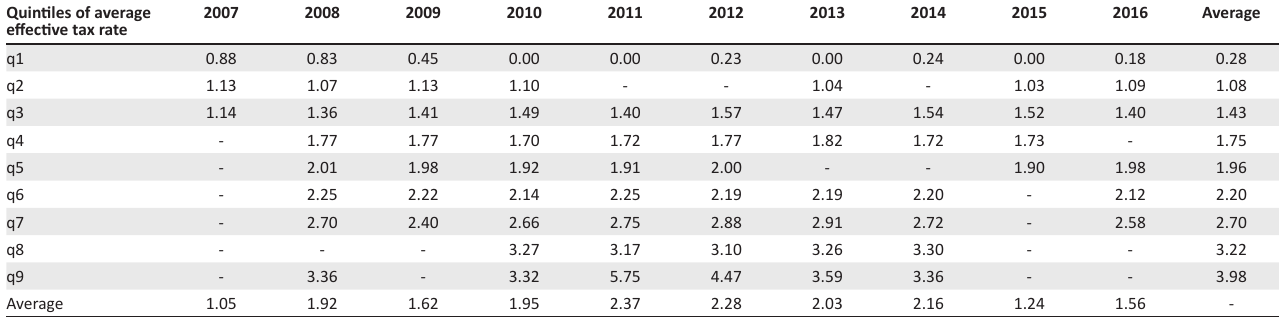
TABLE 2: Quintiles of average effective tax rates by year. Quintiles of average effective tax